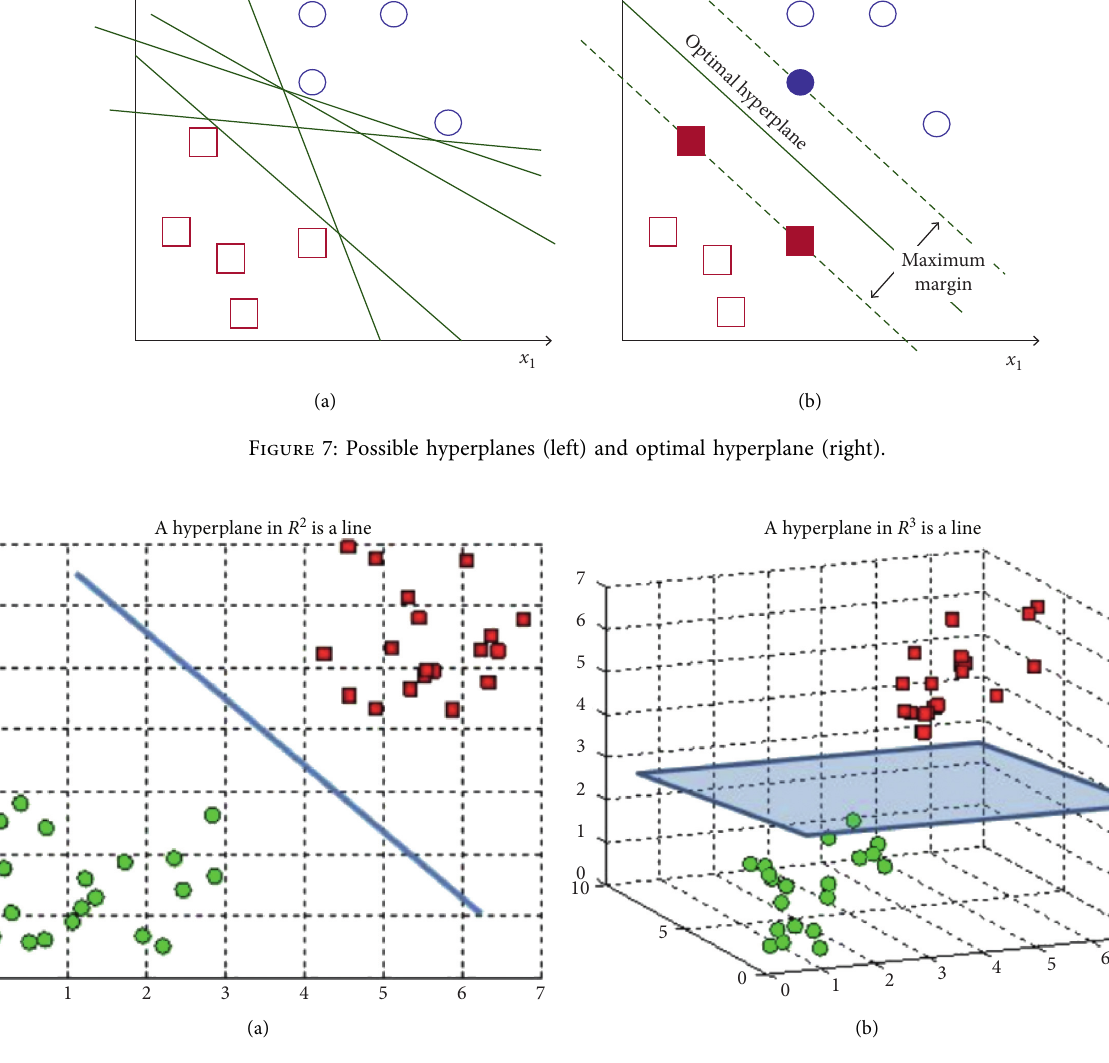
Figure 8: Hyperplanes in 2D (left) and 3D